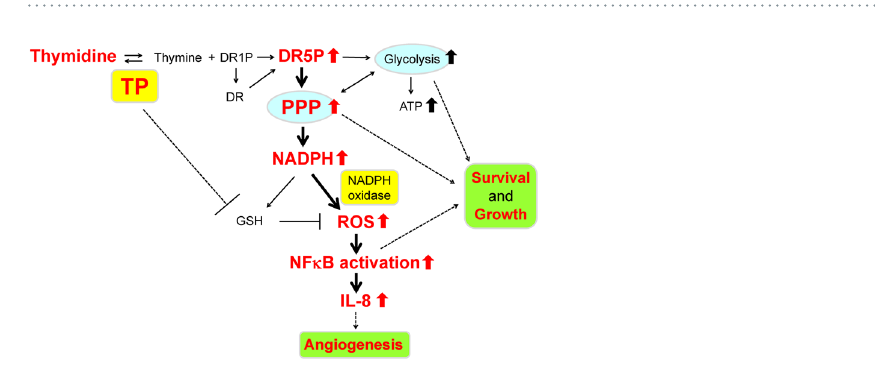
Figure 3. Levels of PPP intermediates in KB/TP cells after addition of thymidine. ( a ) KB/TP were incubated in serum-free medium with 500 μ M thymidine for the indicated times, and levels of metabolites were determined using CE-TOFMS. ( b ) KB cells transfected with DERA siRNA were treated with 500 μ M thymidine for 48 h and the intracellular levels of NADPH were determined. ( c ) Effect of DERA and G6PD downregulation on IL-8 mRNA levels in KB/TP cells. Data are presented as mean ± SD. ∗ P < 0.01.